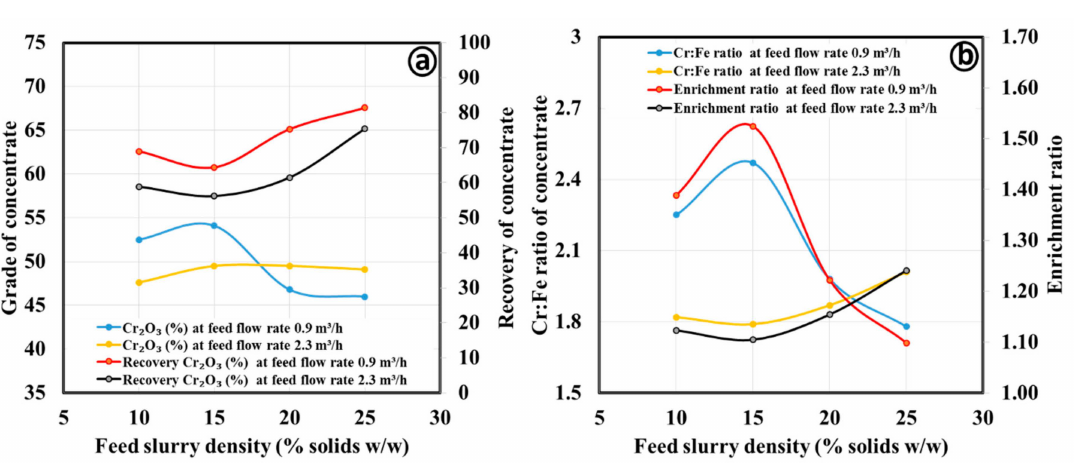
Figure 10. Influence of the feed flow rate and slurry density on the treatment of ultrafine concentrate by the spiral FM1design ( a ) for grade and recovery; ( b ) for Cr:Fe ratio and enrichment ratio of concentrate.